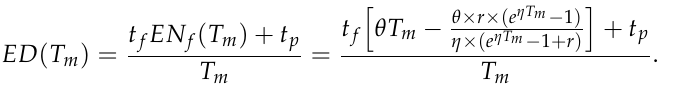
Table 4. Reliability of the most critical machines during the preventive maintenance